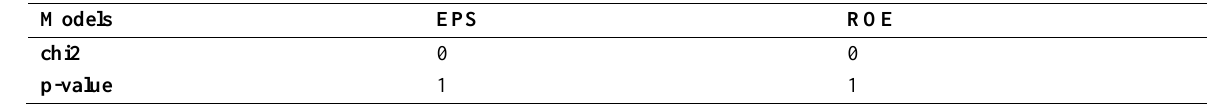
Table-6: Summary of the output of BP-LM Test